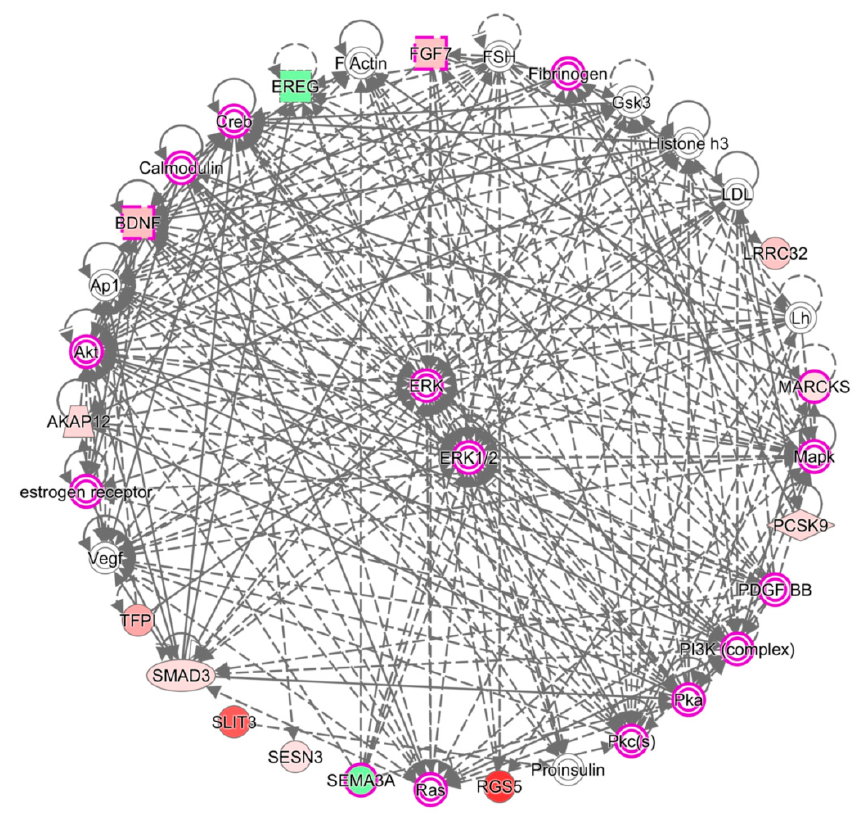
Figure 7. Network analysis by IPA identified molecules associated with the outgrowth of neurite. The network analysis of the 26 candidate genes by IPA software yielded three networks, where 13 genes were grouped into network 1, and are related to cellular movement, cardiovascular system development and function, and organismal development. The purple frames indicate molecules associated with the outgrowth of neurite, with four of our candidate genes, BDNF , FGF7 , MARCKS , and SEMA3A potentially involved. Molecules with a green background indicate down-regulated expressions, and molecules with a red background indicate up-regulated expressions in OA knee chondrocytes compared to normal chondrocytes. The color scales indicate the relative expression values of OA to normal chondrocytes.